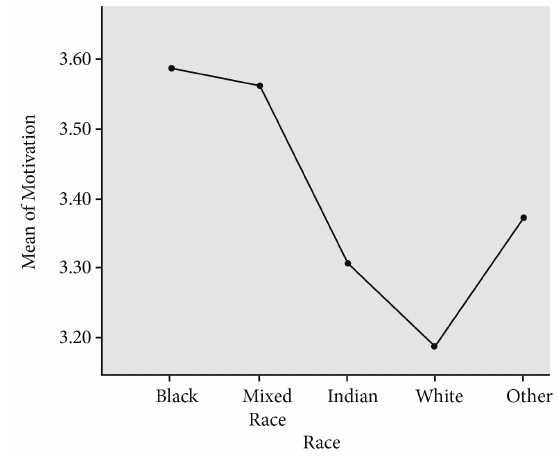
Mean of motivation versus race results in South African design students (Source: Authors, 2020).